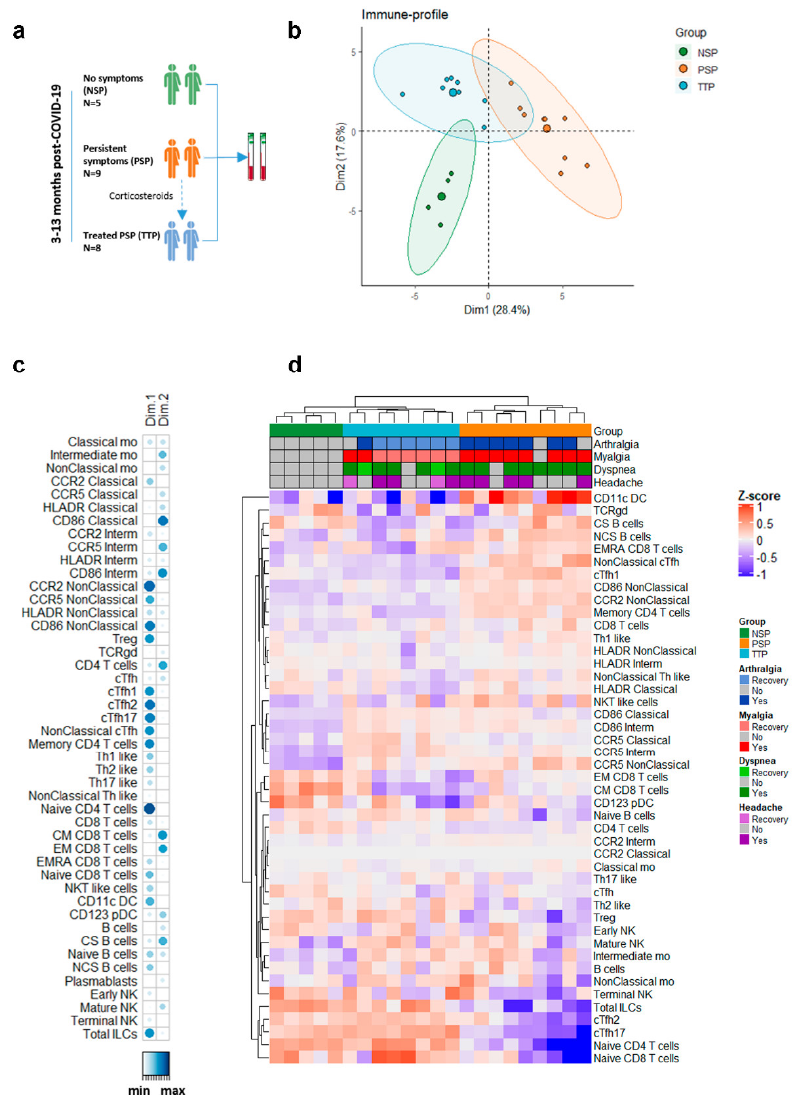
Figure 1. Deep immune profiling detected alterations in post-COVID-19 patients with persistent symptoms, which were corrected with a short course of corticosteroids. ( a ) Study design included three groups of post-COVID-19 patients: five subjects who recovered completely (green, NSP) and nine subjects with persistent symptoms (orange, PSP), eight of whom were sampled again after 4 days of prednisone treatment (blue, TTP). ( b ) Principal component analysis (PCA) based on all flow cytometry data. ( c ) Contribution of each variable to Dimensions 1 and 2 of PCA. ( d ) Unsupervised hierarchical clustering analysis and heatmap of log10-transformed and center-scaled variables.